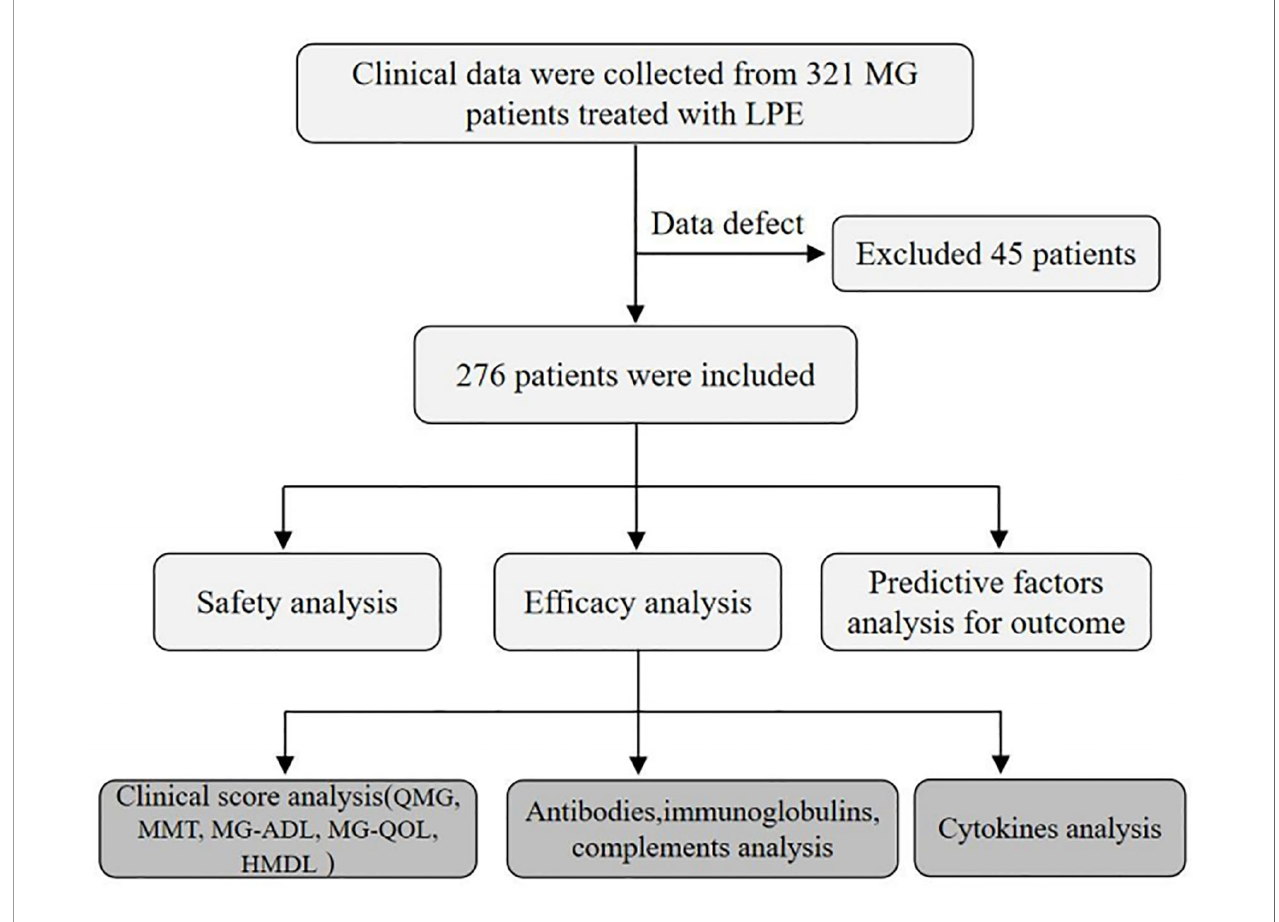
FIGURE 1 | The fl owchart designed for this